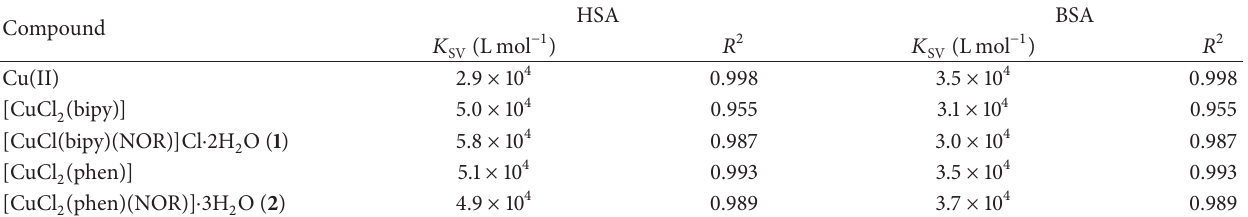
, for the titration of HSA and BSA with the copper complexes at 296 K (standard error, 0.2 × SV